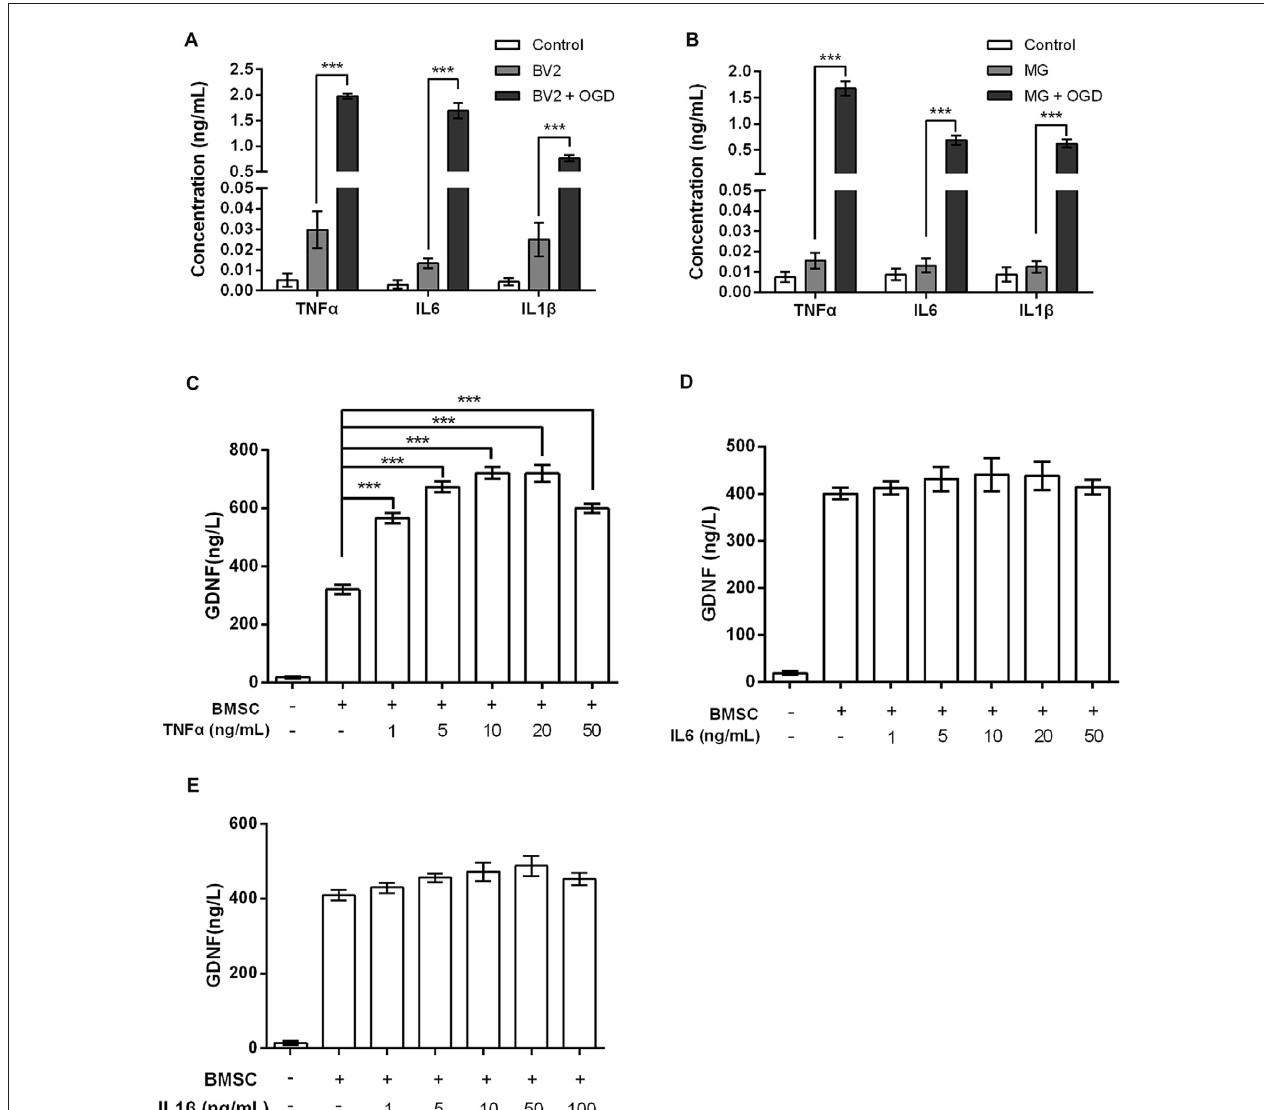
FIGURE 2 | Tumor necrosis factor- α (TNF α ), rather than interleukin-6 (IL6) or interleukin-1 β (IL1 β ), elevates GDNF production by BMSCs. In (A) BV2 and (B) MG, OGD stimulates TNF α , IL6 and IL1 β production. (C) GDNF production by BMSCs is promoted after treatment with TNF α for 24 h. (D) IL6 and (E) IL1 β treatment for 24 h does not significantly change GDNF production by BMSCs. ∗∗∗ P < 0.001.